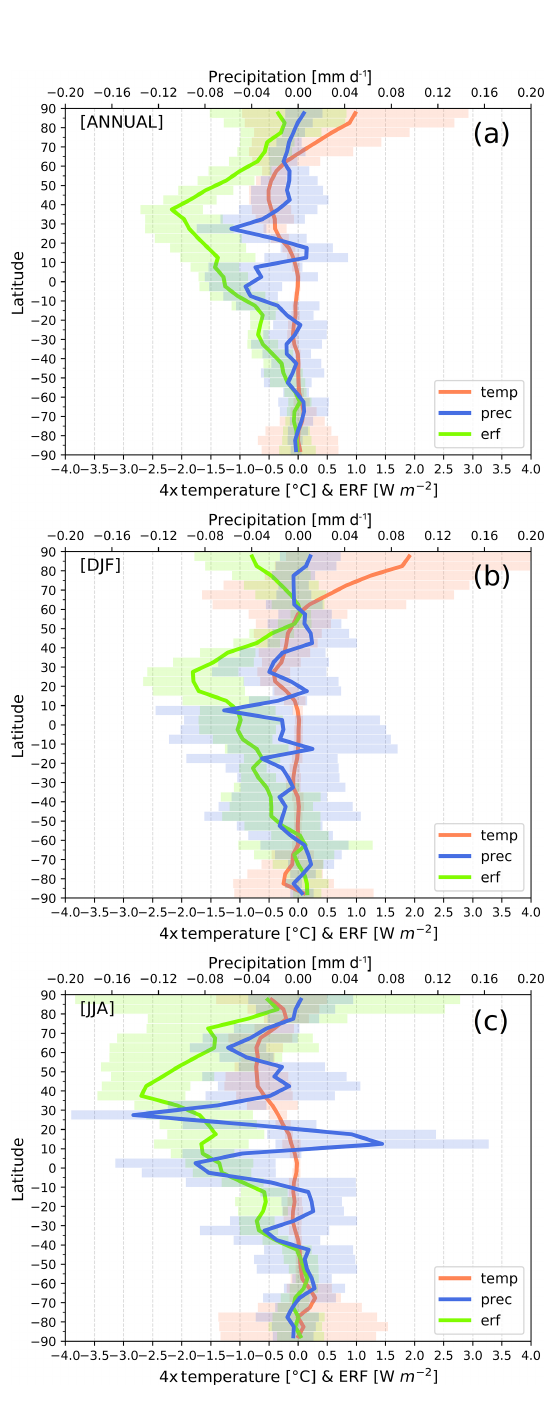
Figure 5. Zonal means of the differences between piClim-aer and piClim-control in ERF (Wm − 2 ) with green line, in near-surface temperature ( ◦ C) with pink line and in precipitation (mmd − 1 ) with blue line for the ensemble of 10 models (a) on an annual basis, (b) for DJF and (c) for JJA. The shaded bands show ± 1 σ of the 10-model ensemble. Mind that the temperature difference has been multiplied by a factor of 4.